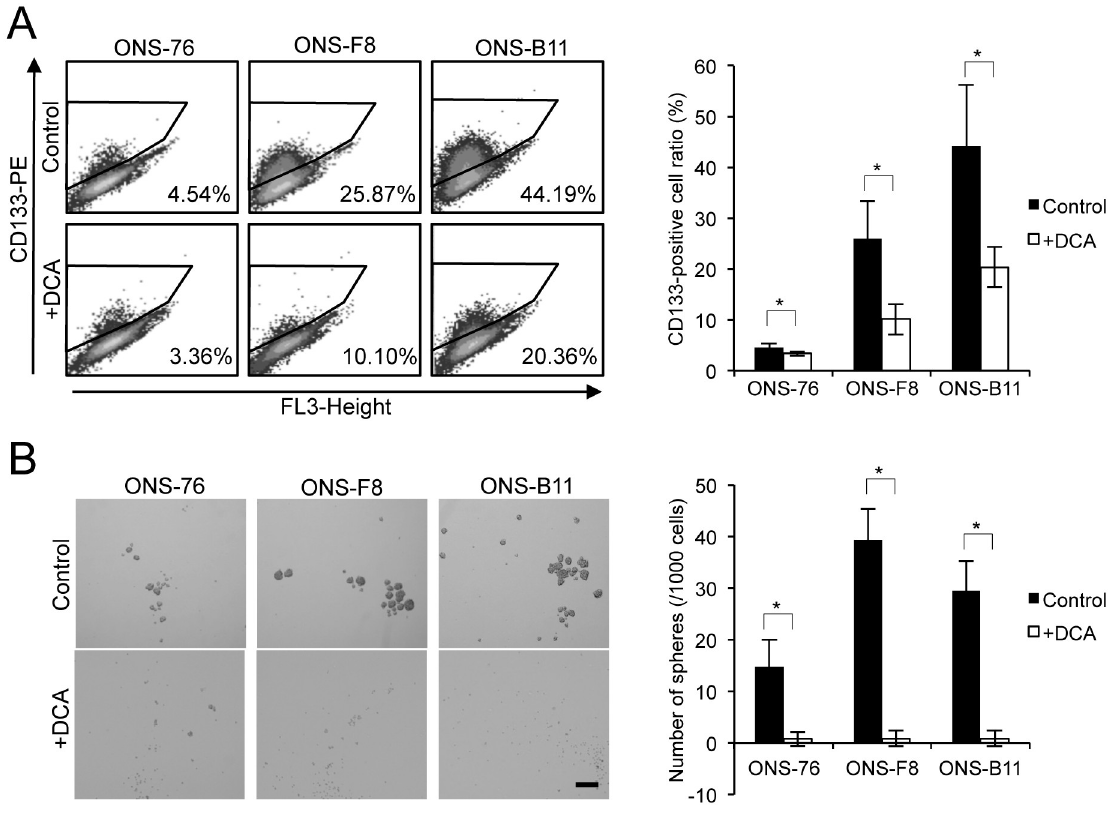
Fig 5. DCA suppressed cancer stem-likephenotypes in vitro . (A) CD133-positive cell ratio (using flow cytometry) and (B) sphere-forming ability in serum-free medium in ONS-76, -F8, and -B11 cells with and without DCA. All quantitative data are means ± S.D. * P < 0.05,Welch’s